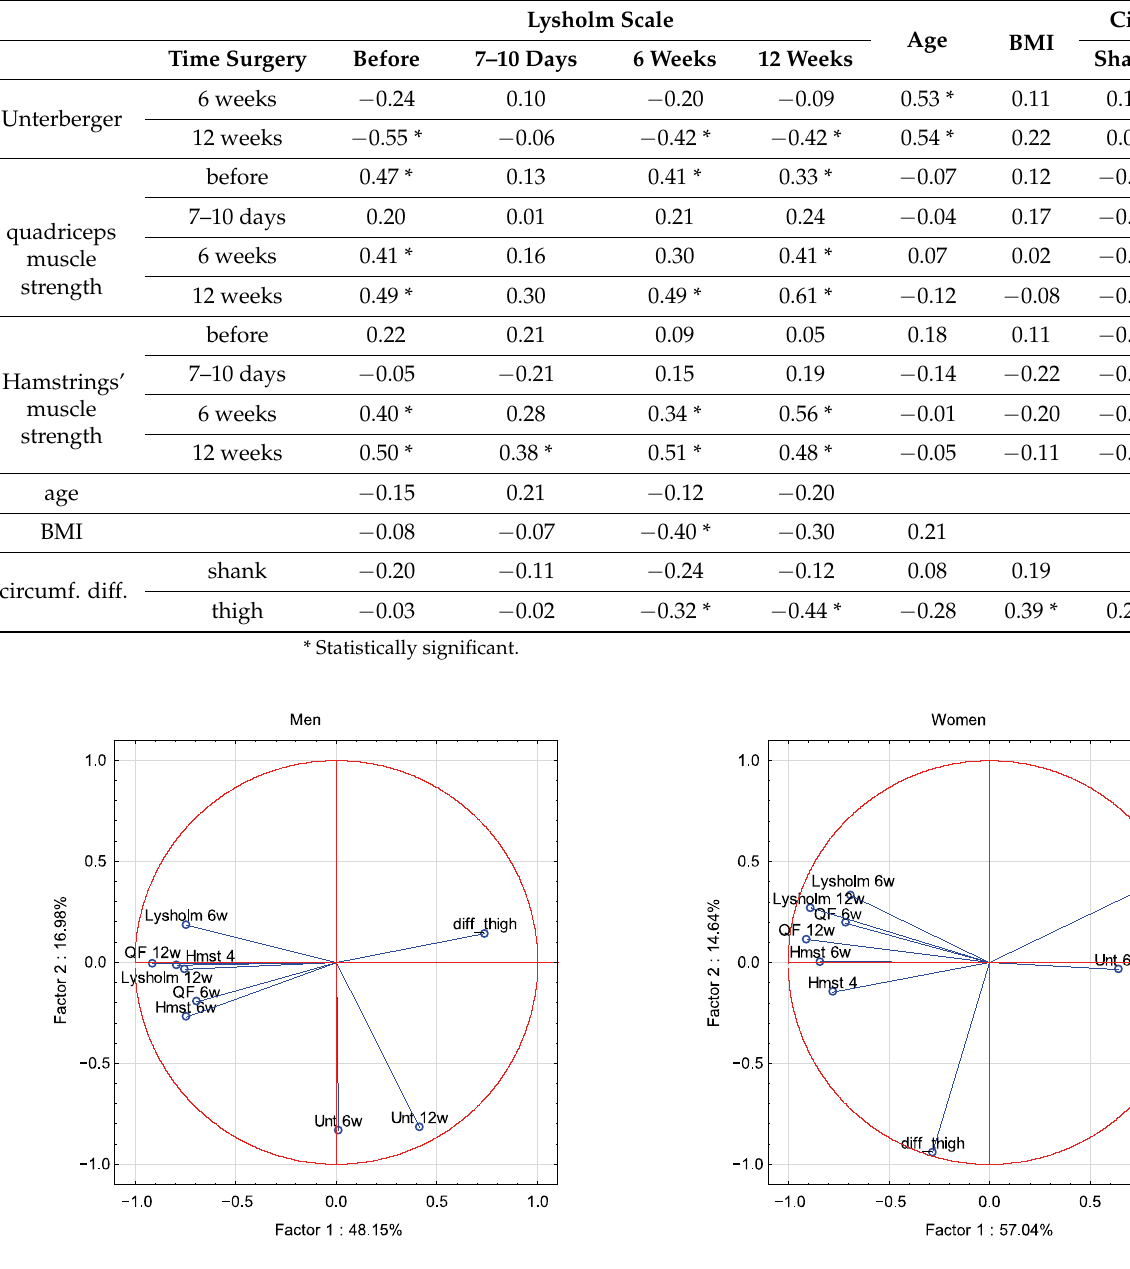
( b ) Figure 3. A graphic illustration of Principal Components Analysis of Lysholm, Unterberger test and muscle strength. Projection of the variables on the factor plane of the first two principal components for the non-dominant ( a ) and dominant ( b ) extremity.